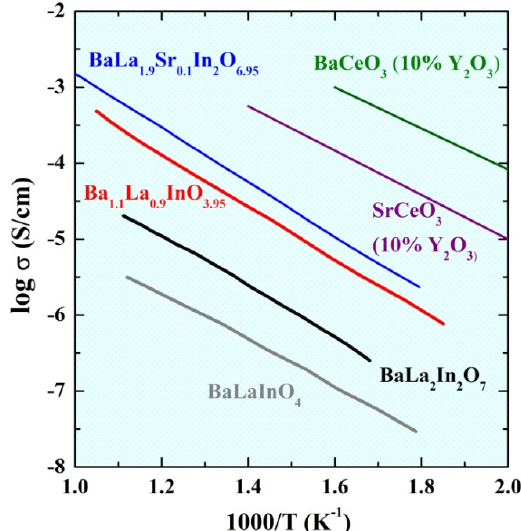
Figure 8. The temperature dependencies of conductivity obtained under wet air for compositions BaLa 1.9 Sr 0.1 In 2 O 6.95 , BaLaInO 4 [41], Ba 1.1 La 0.9 InO 3.95 [41], BaLa 2 In 2 O 7 [54], BaCeO 3 (10 mol % Y 2 O 3 ) [60], SrCeO 3 (10 mol %Y 2 O 3 ) [60].